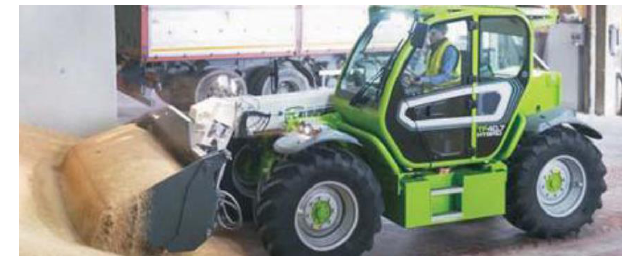
Fig. 36. Merlo 40.7 hybrid telehandler